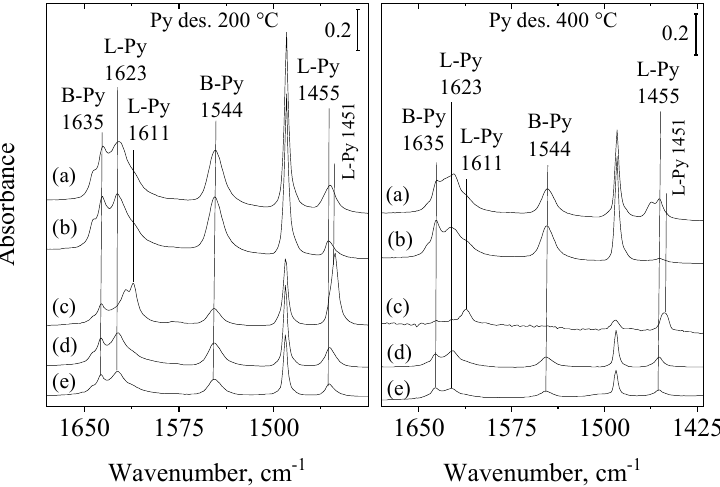
Figure 6. FTIR spectra of adsorbed pyridine on the studied catalysts: ( a ) parent ZSM-5, ( b ) hierar- chical Z-h, ( c ) 10Ni/Z-h, ( d ) 1Pt/Z-h, ( e ) 5Ru/Z-h. Py (6 mbar) was adsorbed on 400 °C dehydrated samples at 200 °C, and desorbed at 200 and 400 °C in high vacuum.